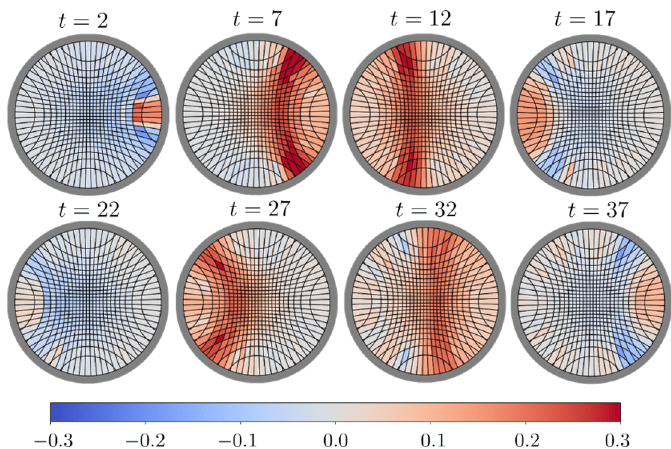
Figure 6. Quenched time dynamics of the reconstructed geometry corresponding to a single mass deformation along the x -axis. The boundary data is pre-processed by smoothing to remove small- scale details (see figure 5 for the corresponding unsmoothed reconstruction). Only the dominant component h 11 is shown here. The relative error is 0 . 03 . E bdy . 0 . 1 .